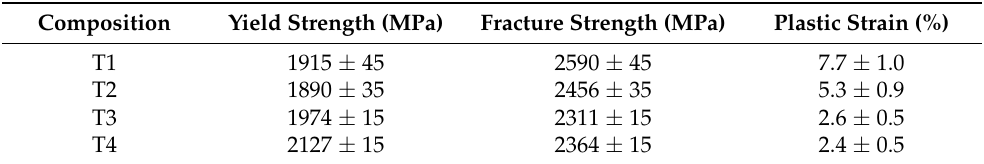
Figure 5. ( a ) Room temperature engineering stress-strain curves of the as-cast samples under compression; ( b , c ) the surface morphology and ( d ) the fracture morphology of the T1 sample after fracture; ( e ) the surface morphology and ( f ) the fracture morphology of the T4 sample. Table 2. The values of the yield strength, the fracture strength, and the plastic strain of the investigated